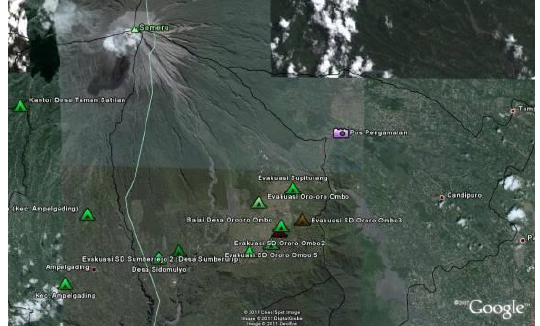
Figure 4. Image on Google Earth with toponym from Google and Field Survey